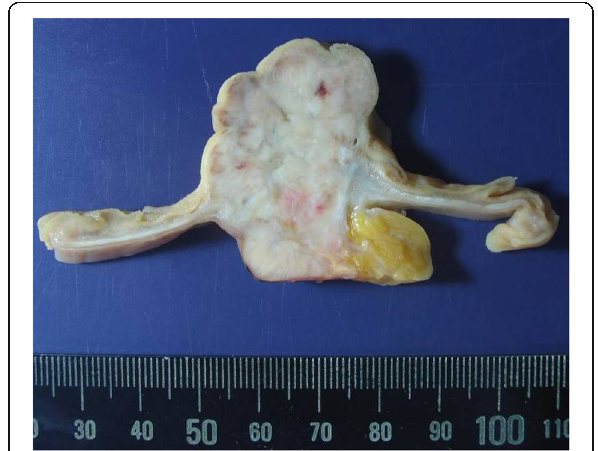
Fig. 5 Grossly coronal resection of gastrointestinal stromal tumor